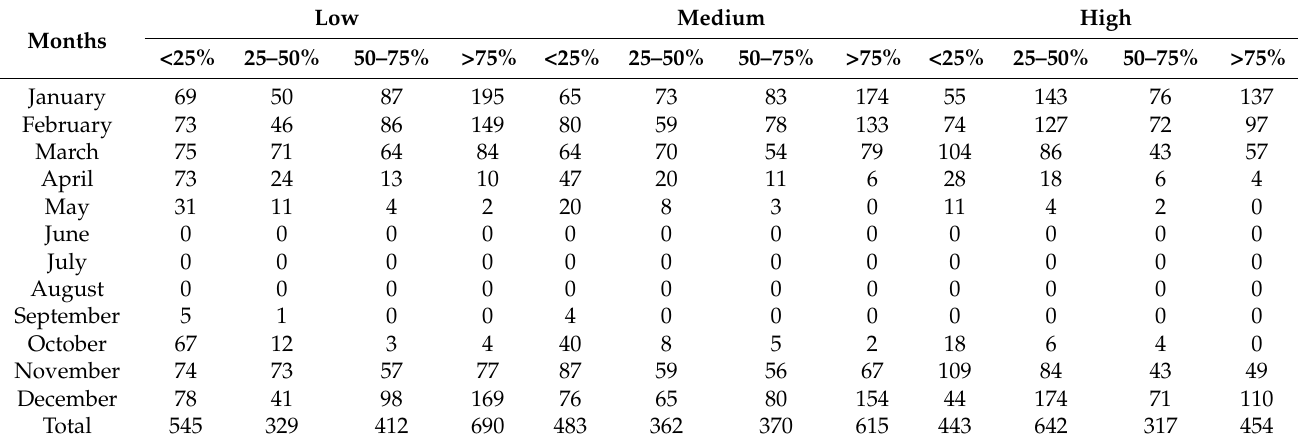
Table 4. Operation hours (h) during the heating season for different load factor ranges and profiles.